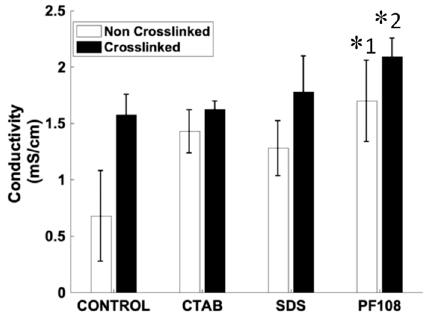
Figure 4. Conductivity values of different surfactant/SWCNT-based hydrogels. * indicates statistically significant difference ( p < 0.05) for non-cross-linked ( * 1) and cross-linked samples ( * 2) of PF108, in comparison with controls.